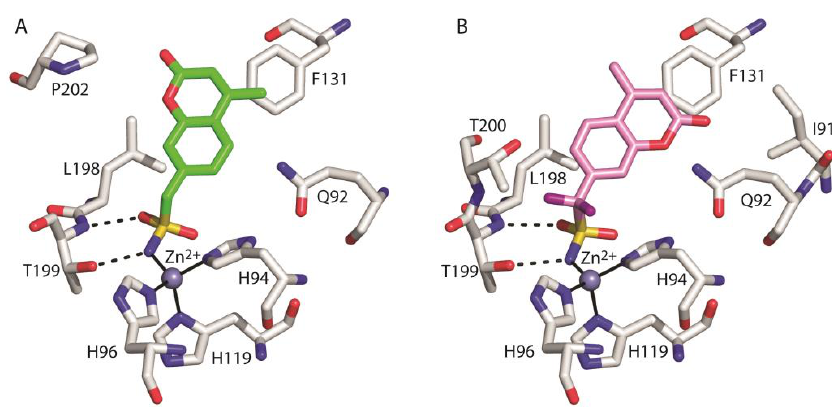
Figure 4. Details of the interactions of compounds 1 ( A ) and 2 ( B ) with the enzyme active site. Residues involved in hydrogen bonds and van der Waals (<4 Å) interactions are shown. Continuous lines indicate zinc ion coordination, whereas dashed lines indicate hydrogen bond distances.